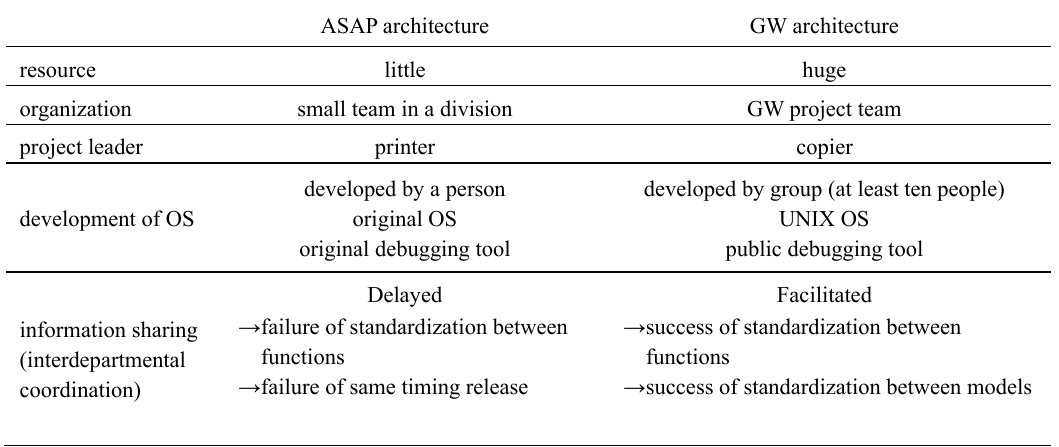
Table 1. Comparison of the development activities between the ASAP and